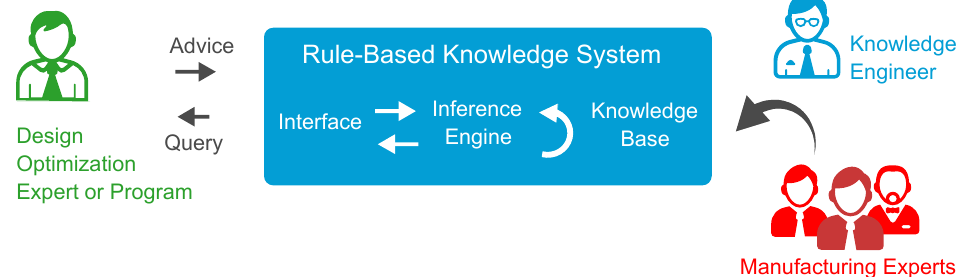
Figure 3. Knowledge-based system and its interface to optimization and experts via a knowledge